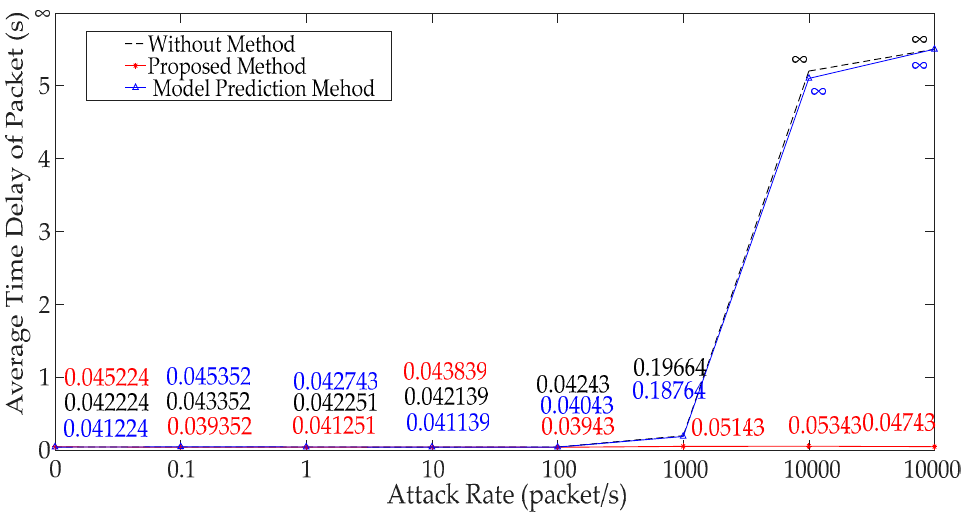
Figure 22. Different time delays using different methods.